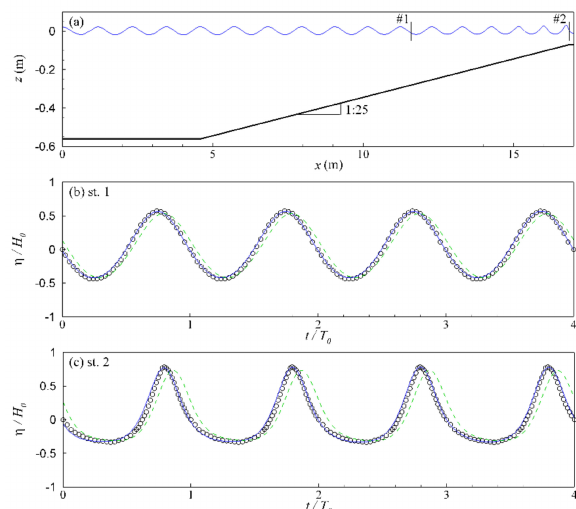
Figure 14. ( a ) The spatial free-surface displacement from FNHS results (solid lines) for non-linear wave shoaling and the bottom configuration (bold solid lines). Comparison of the free-surface displacement time series at ( b ) station 1 and ( c ) station 2: experimental data (circles), FNHS mode (solid lines), and QNHS mode (dashed